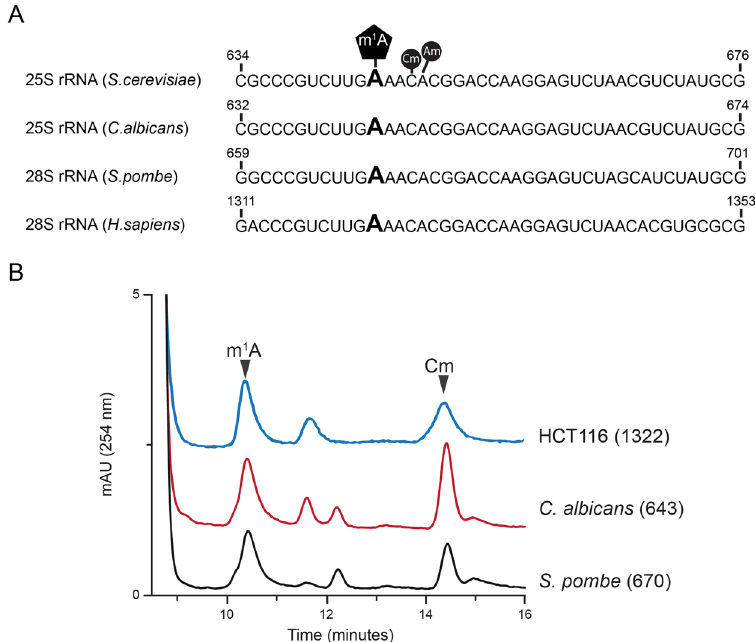
Figure 1. Conservation of the N 1 -methyladenosine in helix 25.1 of 25/28S rRNA. ( A ) rRNA sequence alignment of helix 25.1 from S . cerevisiae , C . albicans , S . pombe and H . sapiens . The m 1 A modified residue is highly conserved within helix 25.1 ( B ) Overlaid RP-HPLC chromatograms of nucleosides derived from fragments isolated using mung bean nuclease assay, containing m 1 A 643 (Ca-Oligo643) isolated from wild-type C . albicans strain RM1000, m 1 A 670 (Sp-Oligo643) isolated from wild-type S . pombe strain CBS356 and m 1 A 1322 (Hs-Oligo1322) isolated from HCT116 cells. Cm (2 ′ -O-ribose methylated cytidine) and Am (2 ′ -O-ribose methylated adenosine) peaks are also